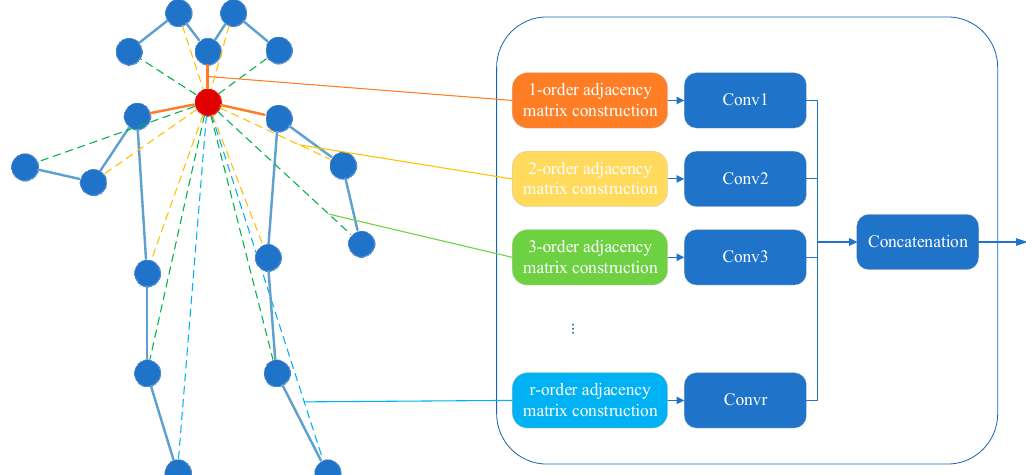
Figure 2. Spatial graph of the skeleton ( left ) and multi-scale aggregate graph convolution module ( right ). In the graph, the solid nodes represent the body joints, and the edges represent the bones that connect the joints. The edges of different colors intuitively reflect the relationship between nodes with different hop connections.